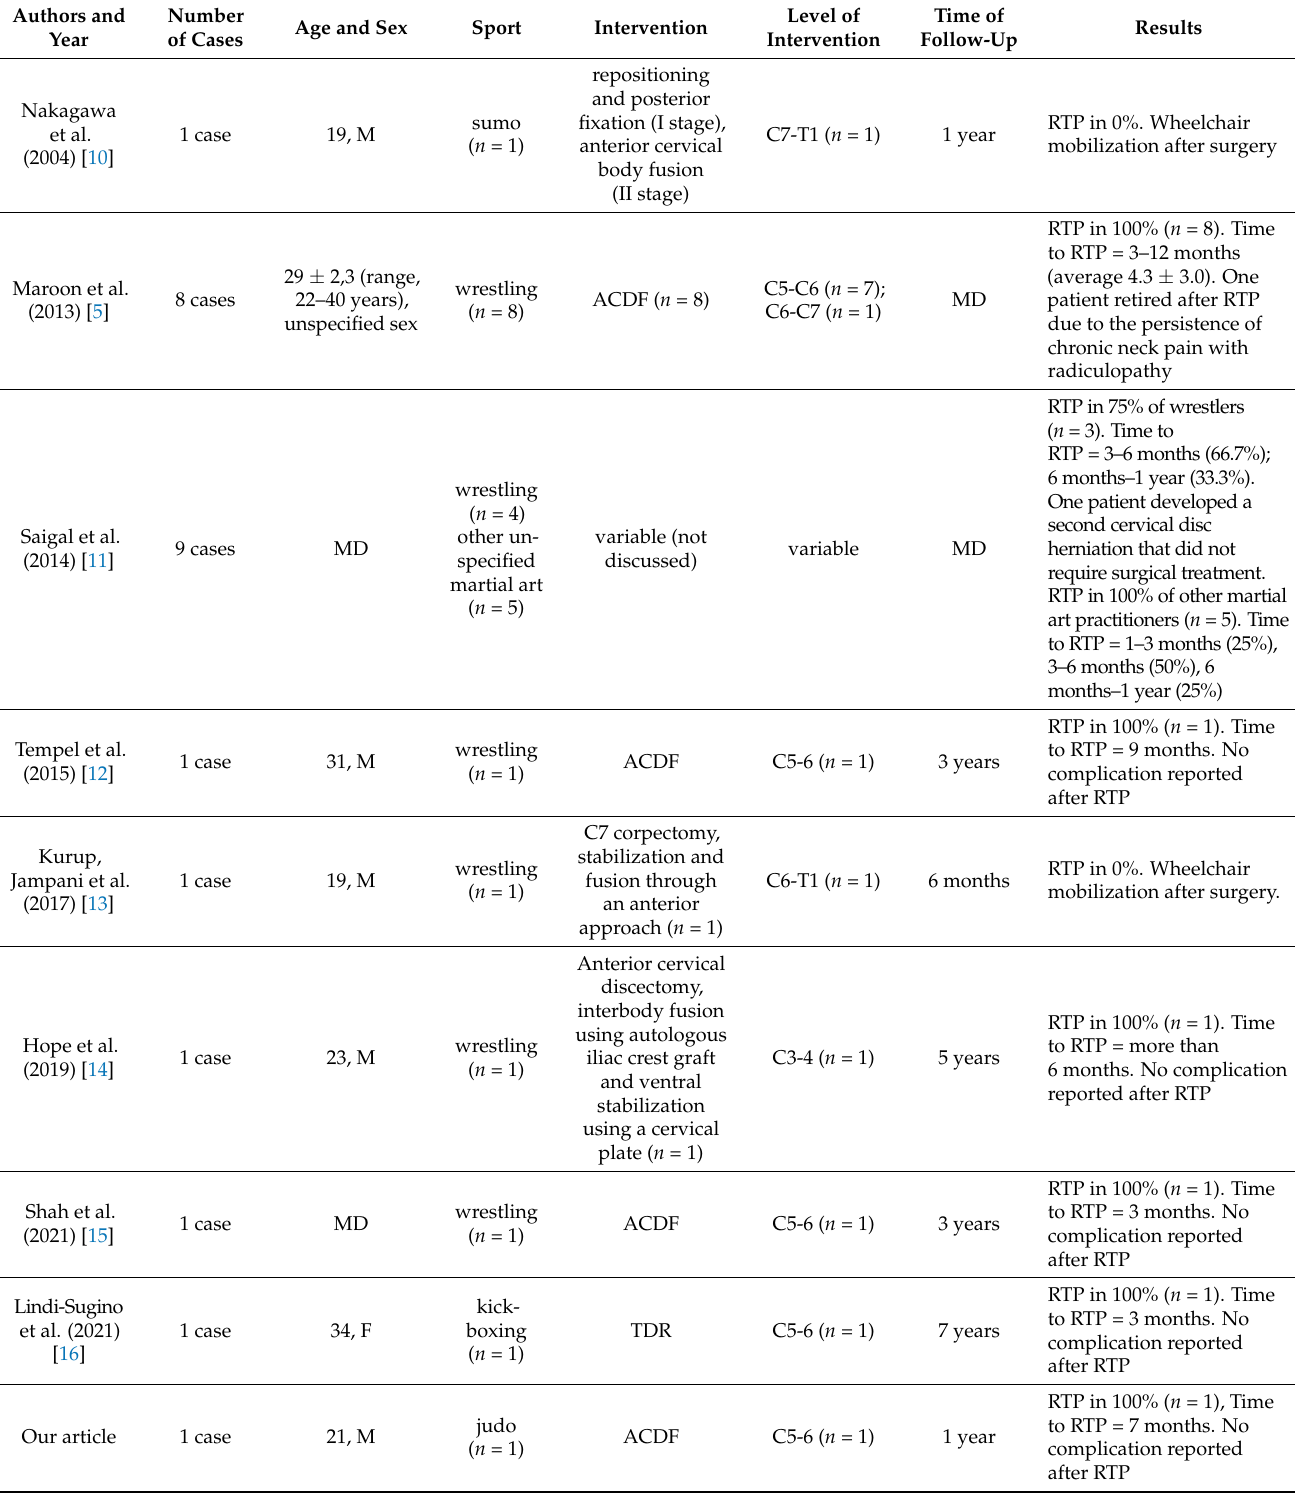
Table 1. Summary of data from studies included in our systematic